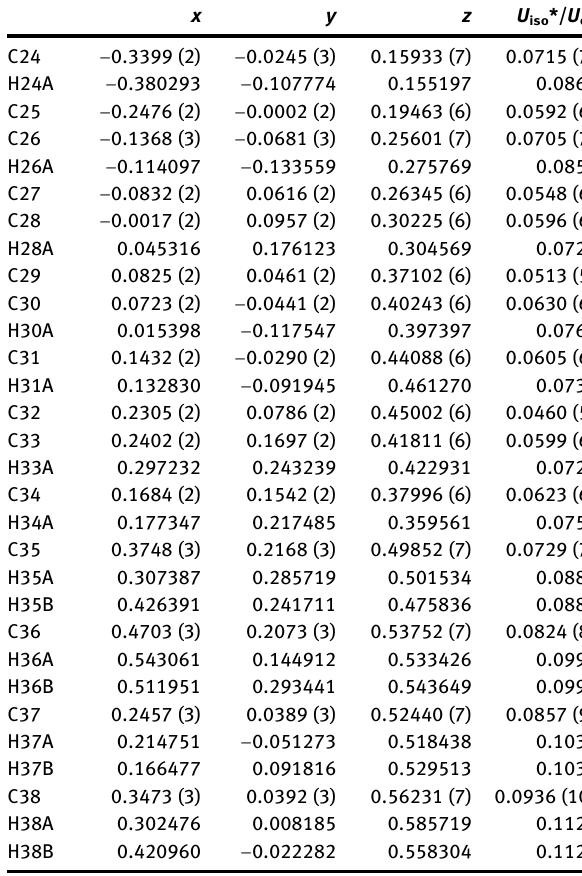
Table  : Fractional atomic coordinates and isotropic or equivalent isotropic displacement parameters (Å 